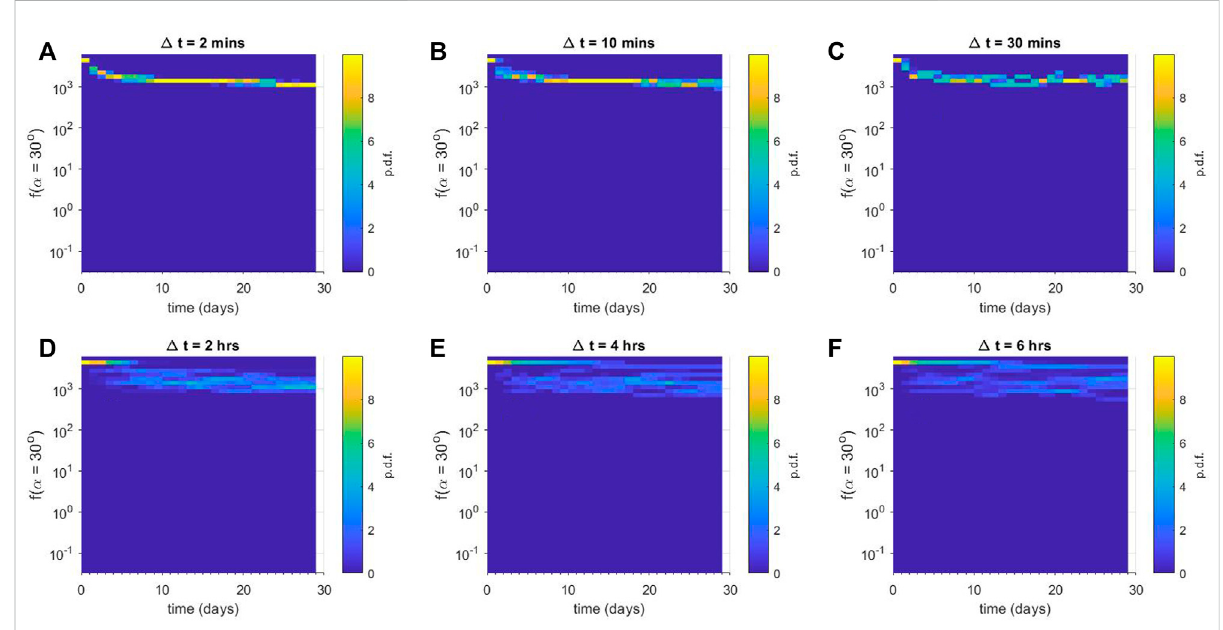
Ensemble results for numerical diffusion experiments using D αα ( L * = 3.5). Each panel shows a column-normalised probability distribution functionforthephasespacedensity f justoutsidetheloss-cone α LC for (A) Δ t =2 min, (B) Δ t =10 min, (C) Δ t =30 min, (D) Δ t =2 h, (E) Δ t =4 h,and (F) Δ t = 6 h. Note that each histogram is displayed using the same vertical binning, giving the histograms a pixelated appearance.